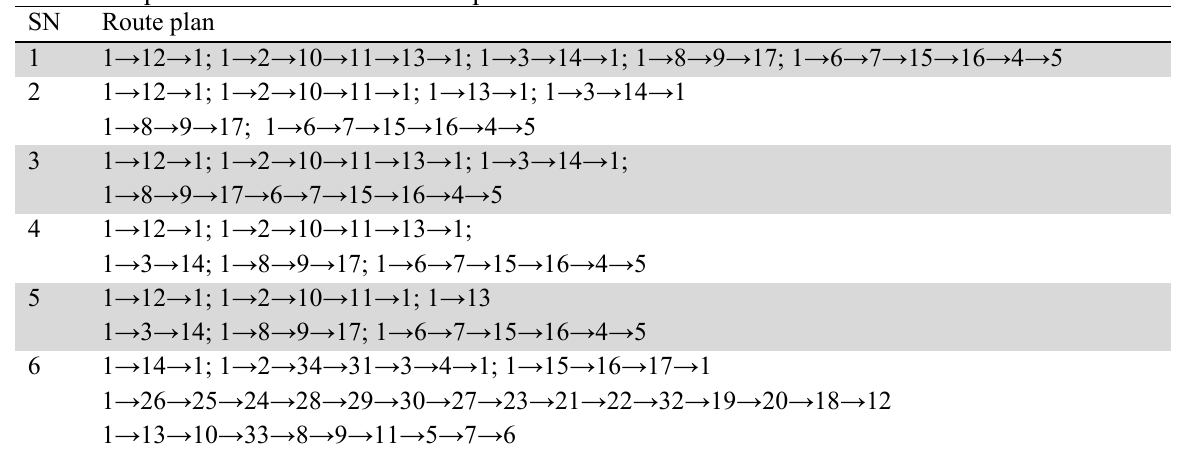
The route plan of the salesman with respect to the best solution of OCMTSP SN Route